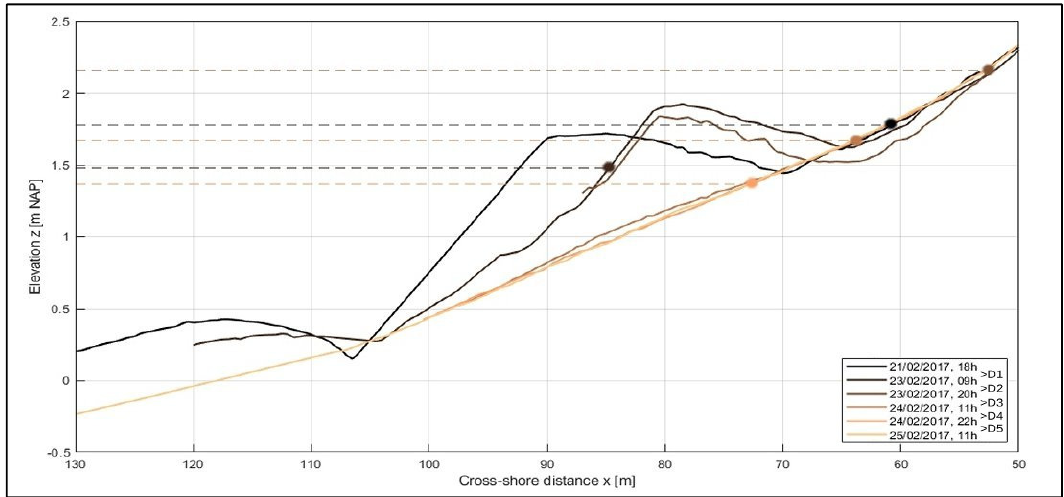
Figure 15 . Low waterbed levels for period D (M4 and M5 in Figure 7) from 21 to 25 February 2017 (excluding 22 February). The dashed lines indicate the total high water level after each subsequent low water period. D1–D5 indicates time periods shown in Figure 16.